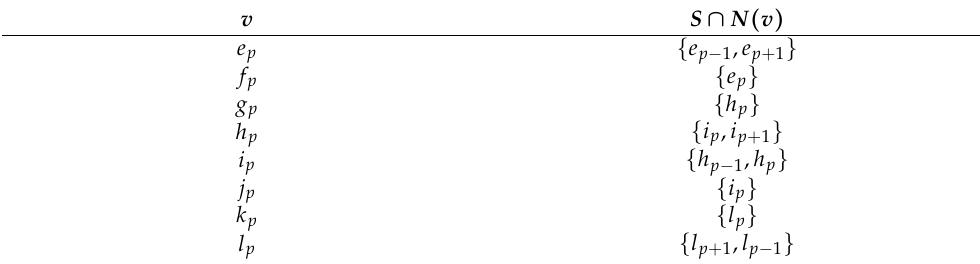
Table 4. Open locating-dominating vertices in H n